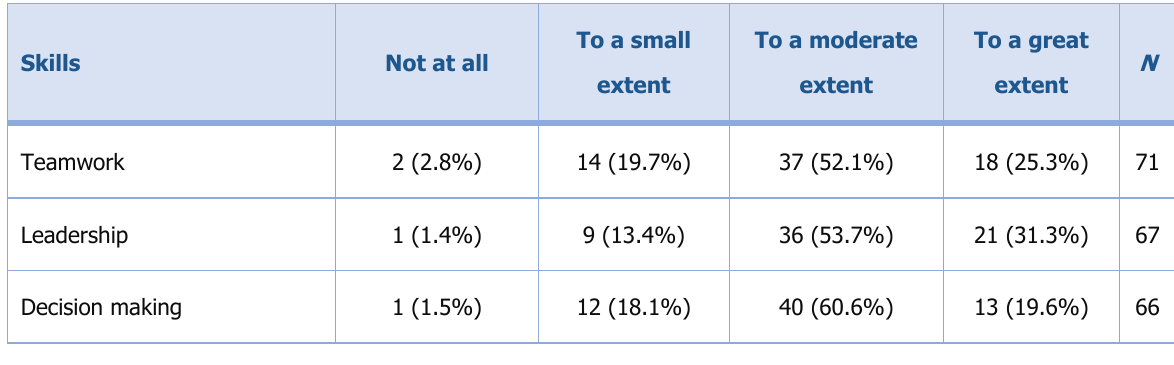
Table 9. 4- H Professionals’ Belief About Skills Gained or Improved by Camp Counselors Because They Attended